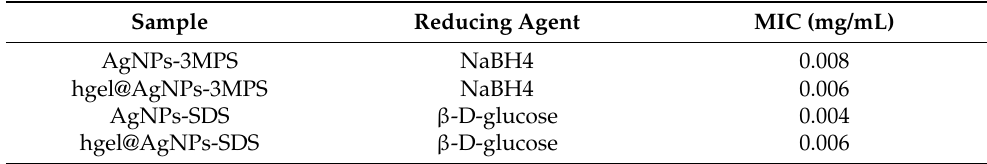
Table 2. Minimum inhibitory concentration (MIC) for S. aureus ATCC 25923 for AgNPs in solution and hgel@AgNPs